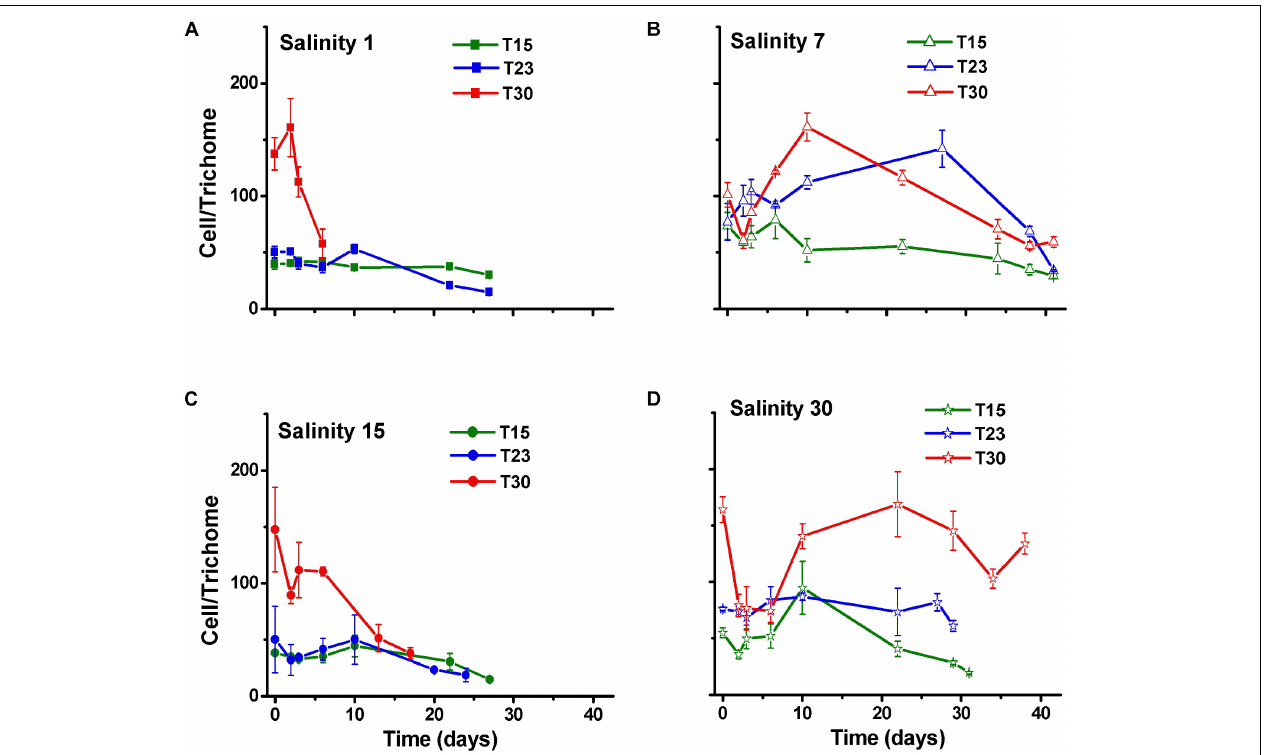
FIGURE 4 | Cell number per trichome ( ± SD; n = 3) of N. spumigena (NODSPU1) observed along the time in the factorial experiment, which analyzed the influence of temperature (T15, T23, T30 ◦ C) and salinity S1 (A) , S7 (B) , S15 (C) , and S30 (D) .